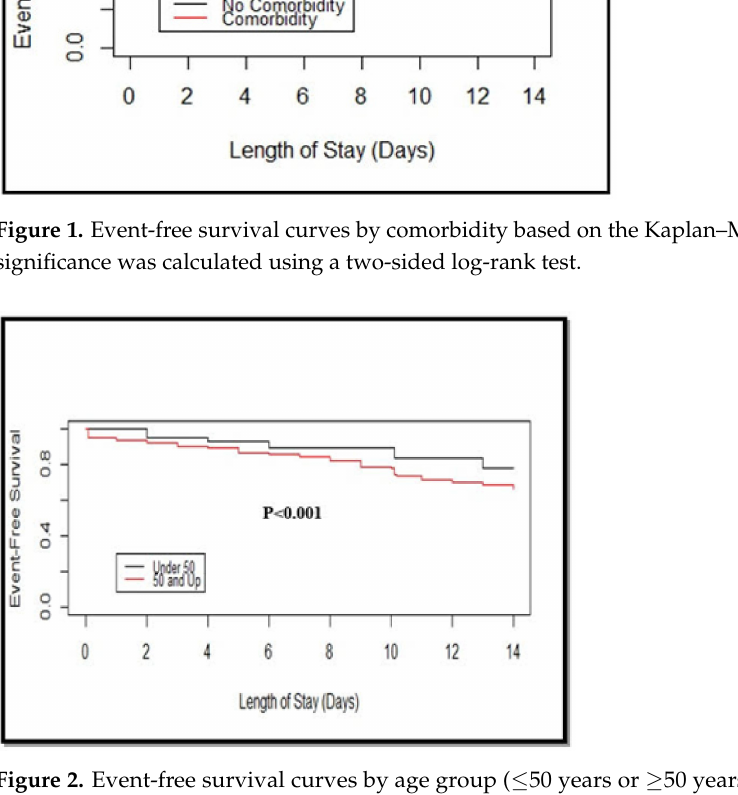
Figure 2. Event-free survival curves by age group ( ≤ 50 years or ≥ 50 years) based on the Kaplan– Meier method. Statistical significance was calculated using a two-sided log-rank